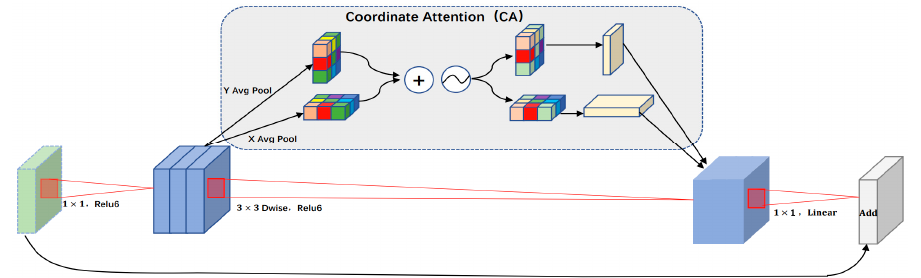
Figure 6. The overall structure diagram after embedding the coordinated attention mechanism, called the Inverted Residuals_CA Block.